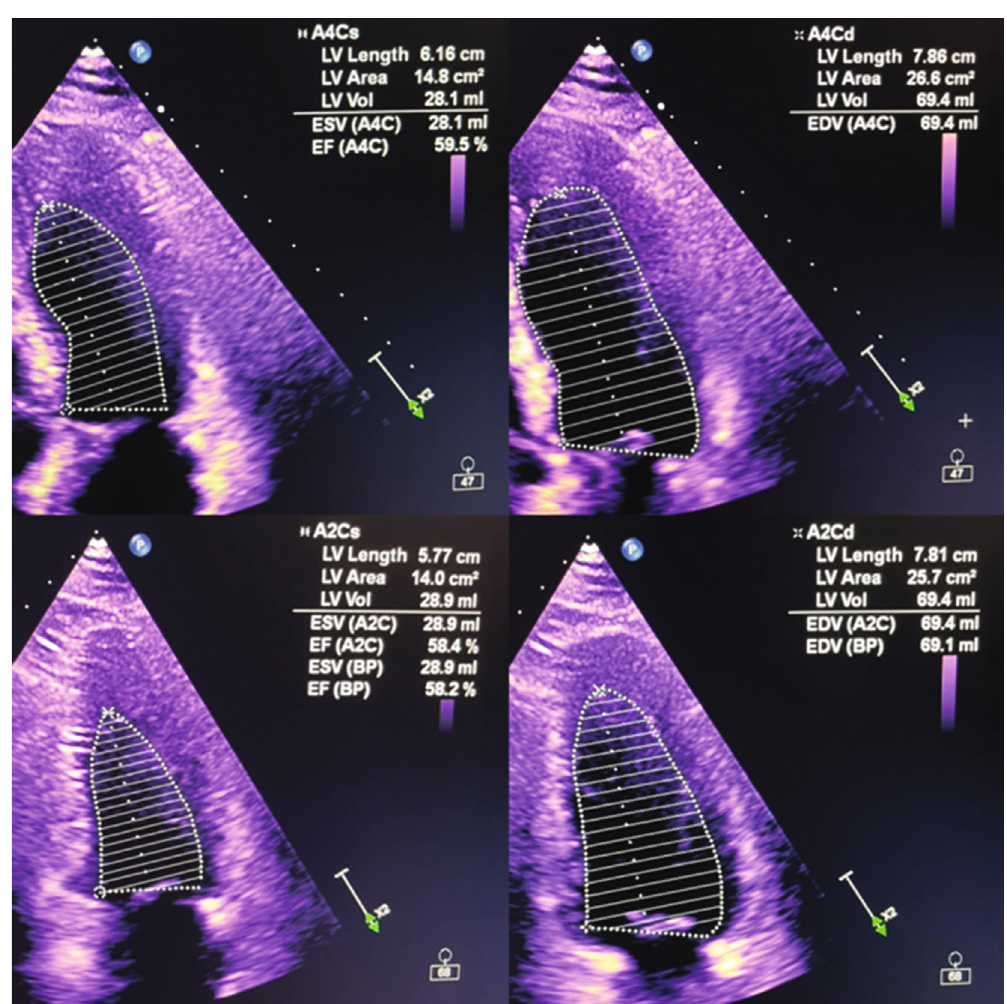
Figure 4: Simpson ’ s method of disc ’ s for measuring ejection fraction at end of systole and end of diastole on discharge demonstrating normal